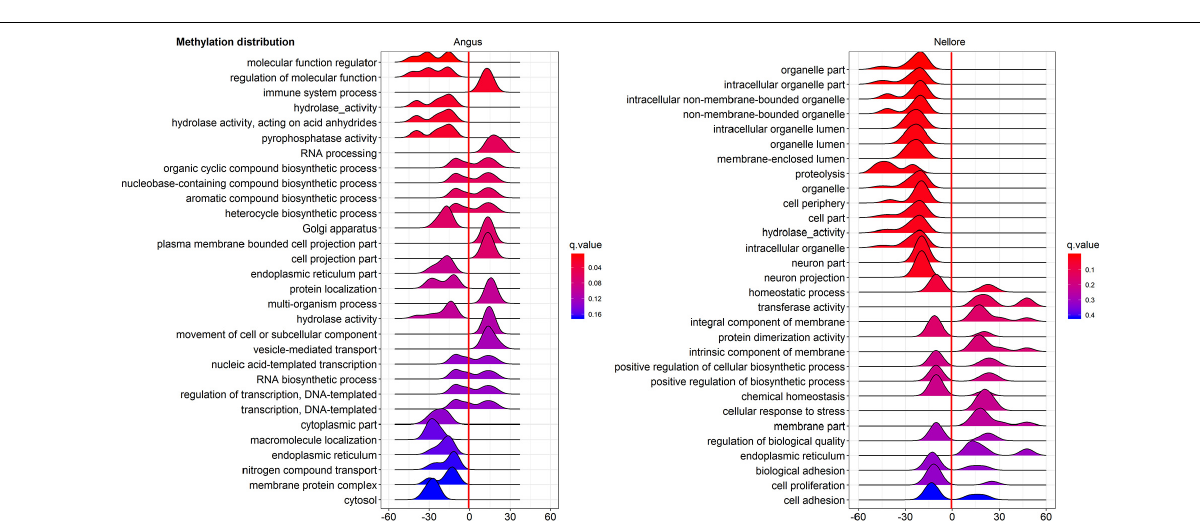
FIGURE 6 | Gene Ontology analysis of DMGs in Angus (left side) and Nellore (right side) in challenge and recovery periods. Peak hight is proportial to the number of differentially methylated genes, color to p value. Negative values indicate hypo-methylation, positive values hyper-methylation during heat